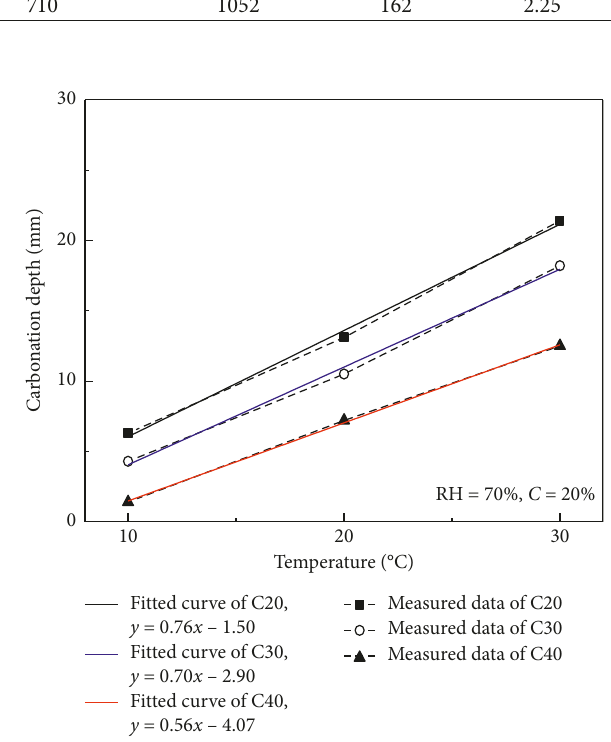
Figure 2: Carbonation depth profiles of concrete with temperature.